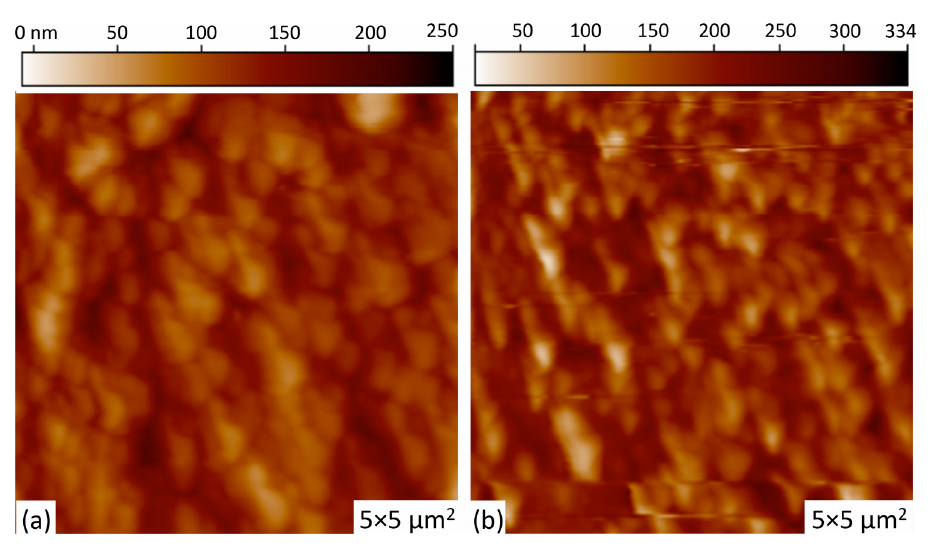
Figure 2. Atomic force microscopy (AFM) topography images of ( a ) the Pd-doped ZnO film surface, and ( b ) the surface of the un-doped ZnO film grown on top of a Pd microstructure array. Both images are 5 × 5 µm 2 , with the greyscale showing ∆ z of 250 nm and 330 nm for ( a ) and ( b ),